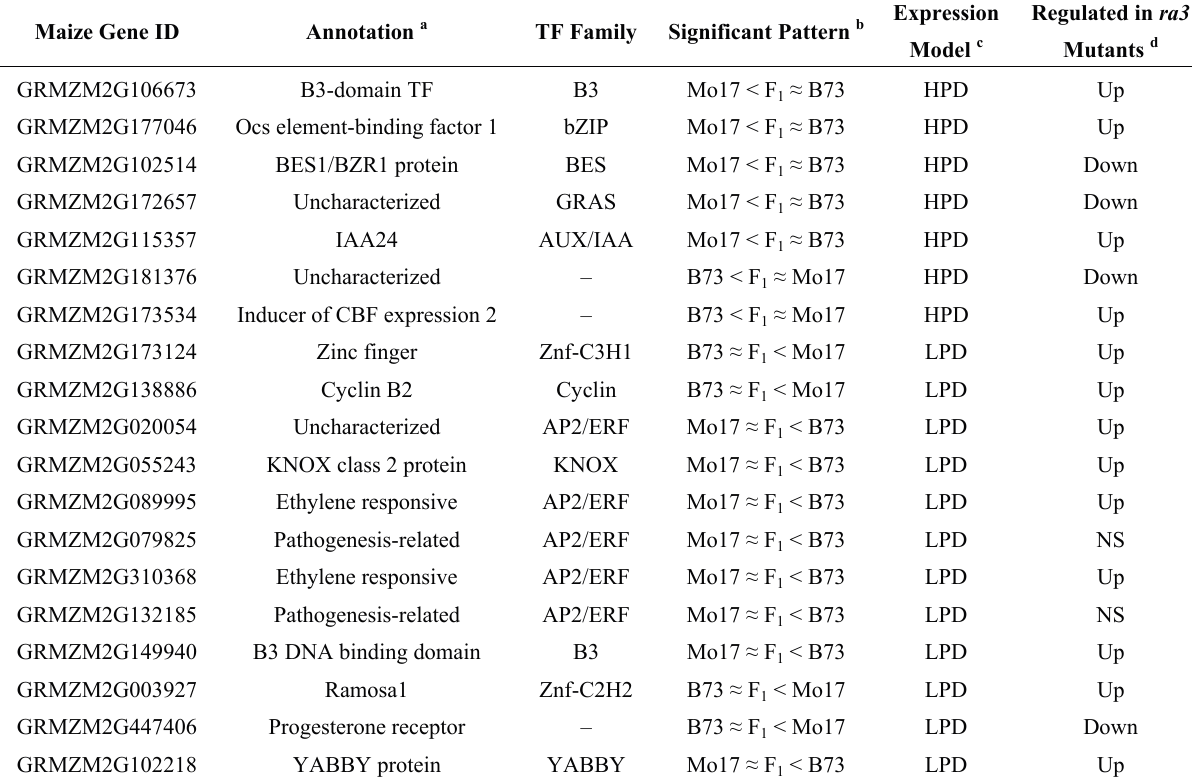
Table 6. Differentially expressed maize genes were identified as putative TFs. Maize Gene